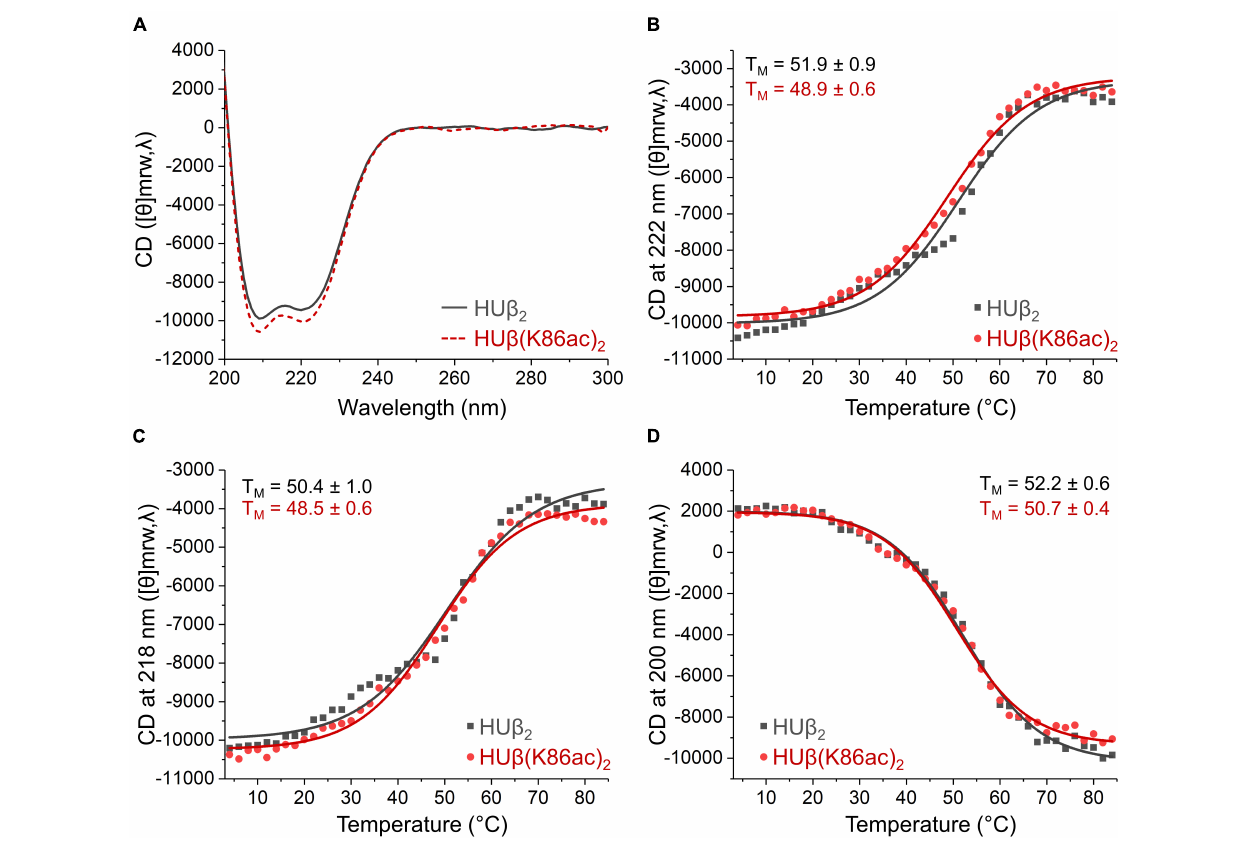
FIGURE 5 | Effect of acetylation at Lys86 of E. coli HU β 2 homodimer on secondary structure and thermal stability analyzed by circular dichroism. Data of wild-type and acetylated dimers are shown in gray or red lines, respectively. (A) CD spectra from 200 to 300 nm measured at 20 ◦ C showing the characteristic α -helix signals with two negative bands of similar magnitude around 210 and 220 nm. (B–D) Melting temperature (T M ) of the protein determined by CD signal from 4 to 84 ◦ C at 222 (B) , 218 (C) , and 200 (D)